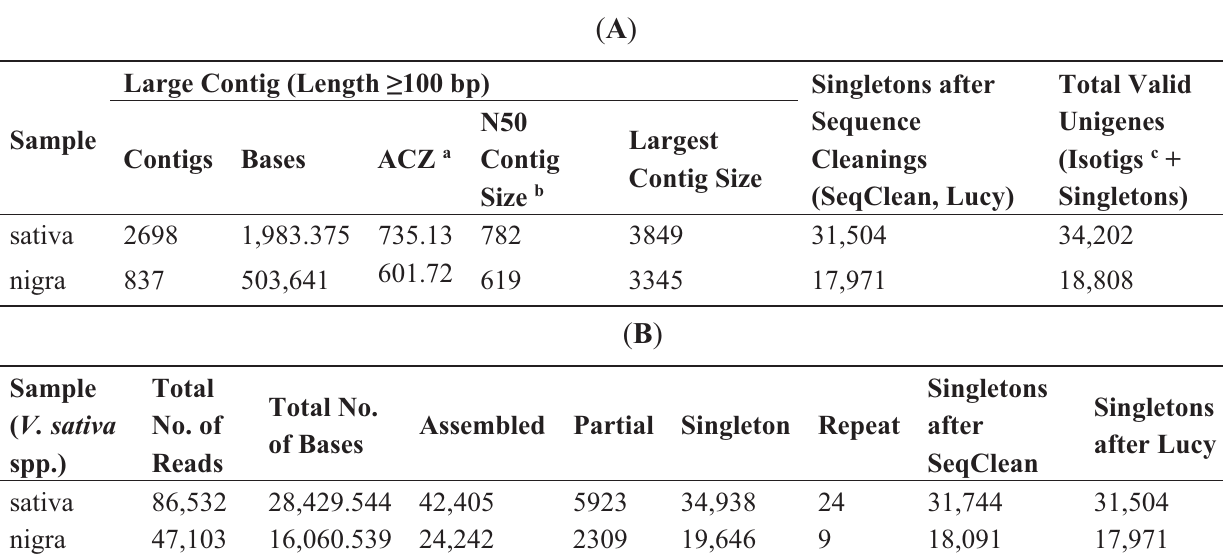
Table 1. Summary of de novo assembly of transcriptome sequences. Sizes of unigenes ( A ) and singletons ( B ) found in the Vicia sativa nigra and sativa